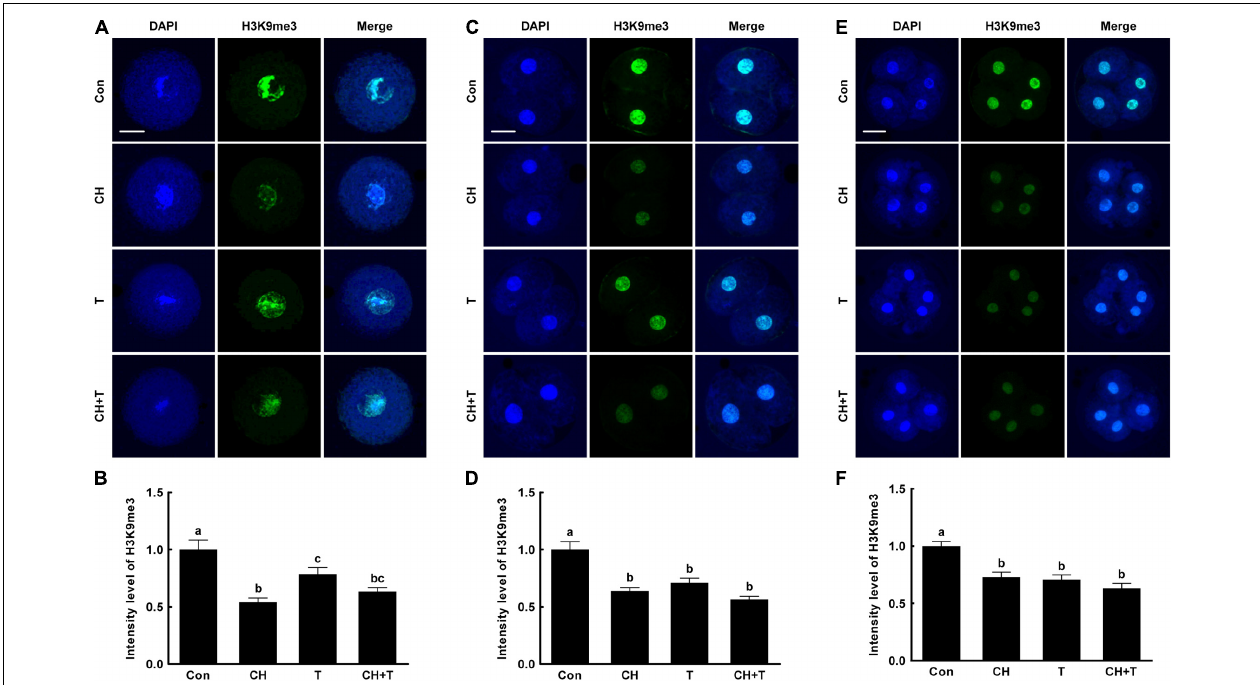
FIGURE 3 | Effects of chaetocin, TSA, and the combination on H3K9me3 levels in porcine SCNT embryos. (A) Representative immunofluorescent images of H3K9me3 at the pronuclear stage. Green and blue fluorescence indicate H3K9me3 and nuclei, respectively. Bar = 50 µ m. (B) Quantification of fluorescence intensity at the pronuclear stage ( n = 20 per group). (C) Representative immunofluorescent images of H3K9me3 at the two-cell stage. Green and blue fluorescence indicate H3K9me3 and nuclei, respectively. Bar = 50 µ m. (D) Quantification of fluorescence intensity at the two-cell stage ( n = 17 per group). (E) Representative immunofluorescent images of H3K9me3 at the four-cell stage. Green and blue fluorescence indicate H3K9me3 and nuclei, respectively. Bar = 50 µ m. (F) Quantification of fluorescence intensity at the four-cell stage ( n = 20 per group). The data are from three independent experiments and are means ± SEM. Values with different superscripts differ significantly ( P < 0.05). Con, control; CH, chaetocin; T,